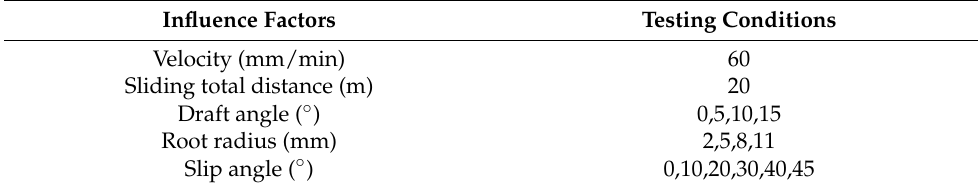
Table 1. Experimental conditions of tread rubber